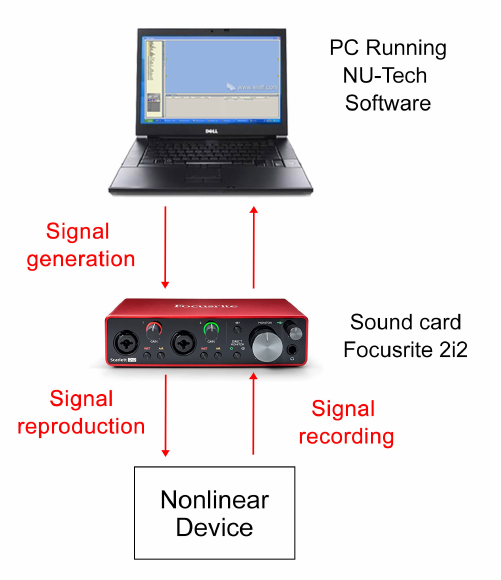
Figure 5. Block diagram of the acquisition procedure for the emulated